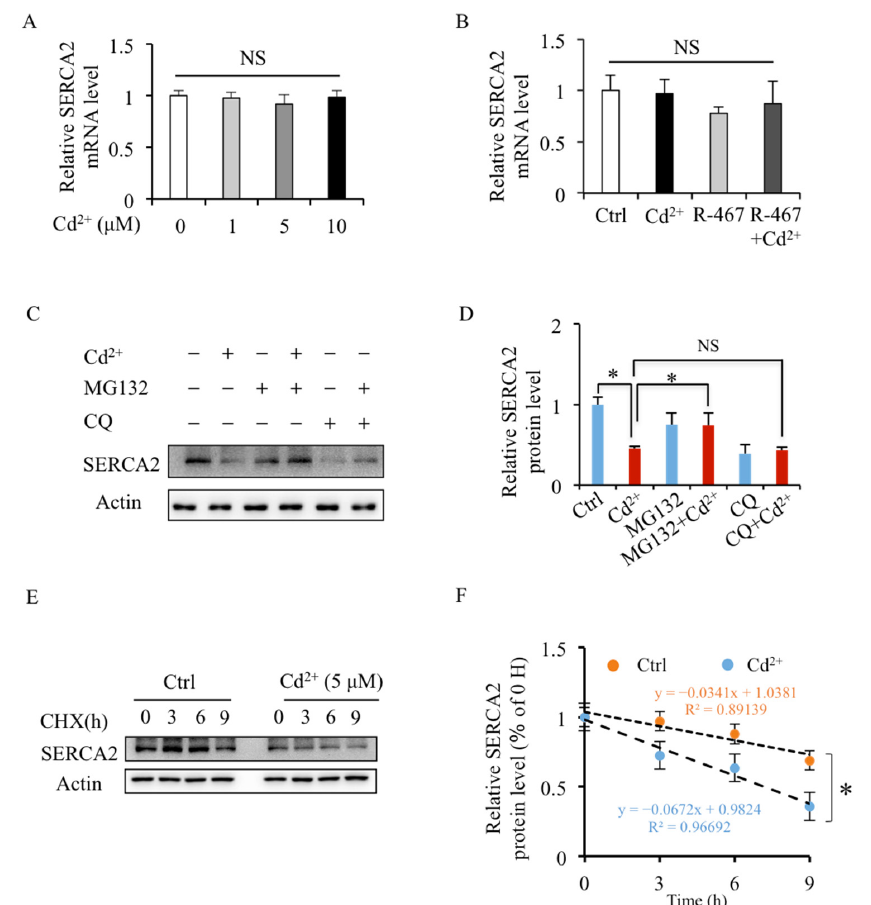
Figure 5. Effects of Cd 2+ on SERCA2 stability in mRTEC cells. ( A , B ) After being treated with Cd 2+ (0–10 μ M) for 24 h or treated with Cd 2+ (5 μ M) or Cd (5 μ M) + R-467 (1 μ M) for 24 h, mRTEC cells were collected for RNA extraction, and the SERCA2 mRNA levels detected by RT-PCR. ( C ) Effects of MG132 and CQ on Cd 2+ -induced degradation of SERCA2. The mRTEC cells were pretreated with CQ (20 μ M) for 1 h, followed by treatment with Cd 2+ (5 μ M) for 24 h, or Cd 2+ (5 μ M) for 18 h + MG132 (10 μ M) for 6 h, and then the proteins were extracted for Western blotting analysis. ( E ) Effects of Cd 2+ on half-life of SERCA2 protein. Cells were treated with Cycloheximide (CHX) (10 μ g/mL) for 3 and 6 h or pretreated with Cd 2+ (5 μ M) for 24 h, and the protein was extracted for Western blotting analysis. ( D , F ) Quantification of the relative protein levels of SERCA2 was performed using the software Image J 1.54c. * indicates statistical significance between control and Cd 2+ treatment or between treatments. NS: no significant difference. ( n = 4 well cells/group) p < 0.05, using one-way ANOVA followed by Duncan’s multiple range test ( A , B , D ) and Student’s t -test ( F ).